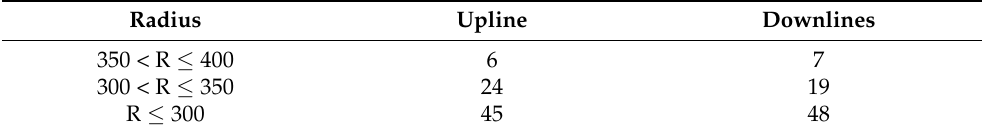
Table 19. Distribution of curves.